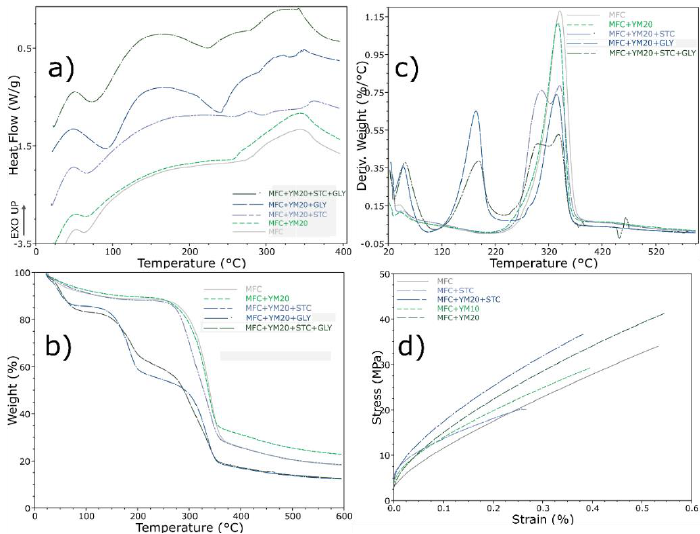
Figure 5. ( a ) Di ff erential scanning calorimetry and ( b ) thermogravimetric analysis with its ( c ) first derivative for the films containing yerba mate extract and ( d ) stress − strain curves for MFC films performed by